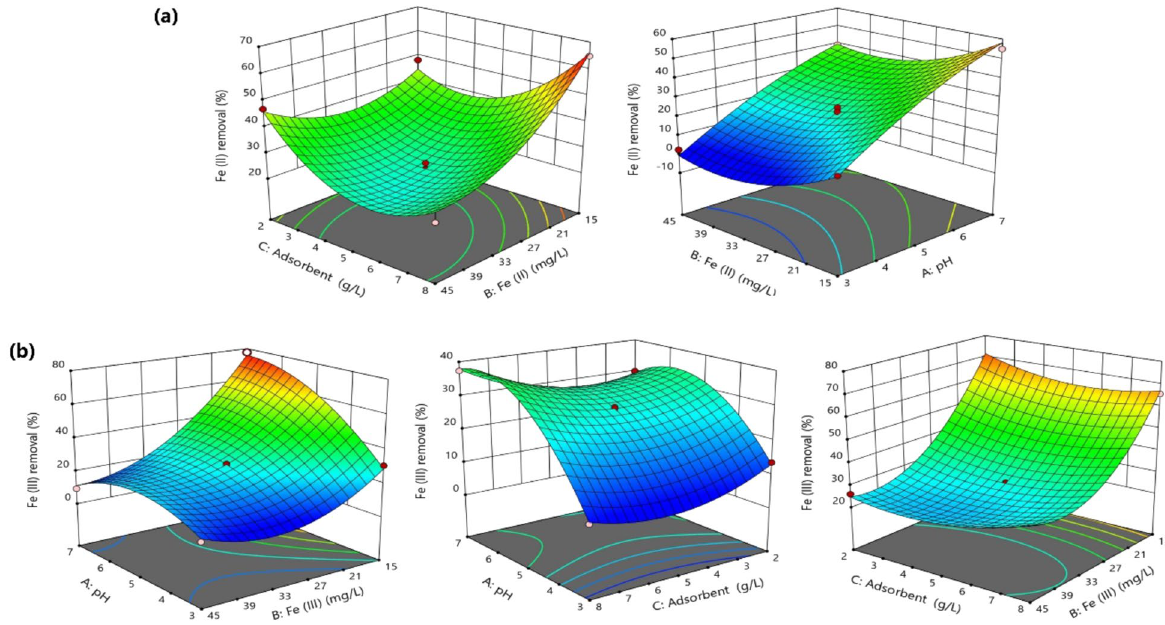
Figure 3. 3-D response surface plots for the adsorption of Fe(II) ( a ) and Fe(III) ( b ) using cellulose nanocrystals/graphene oxide film from a single system.